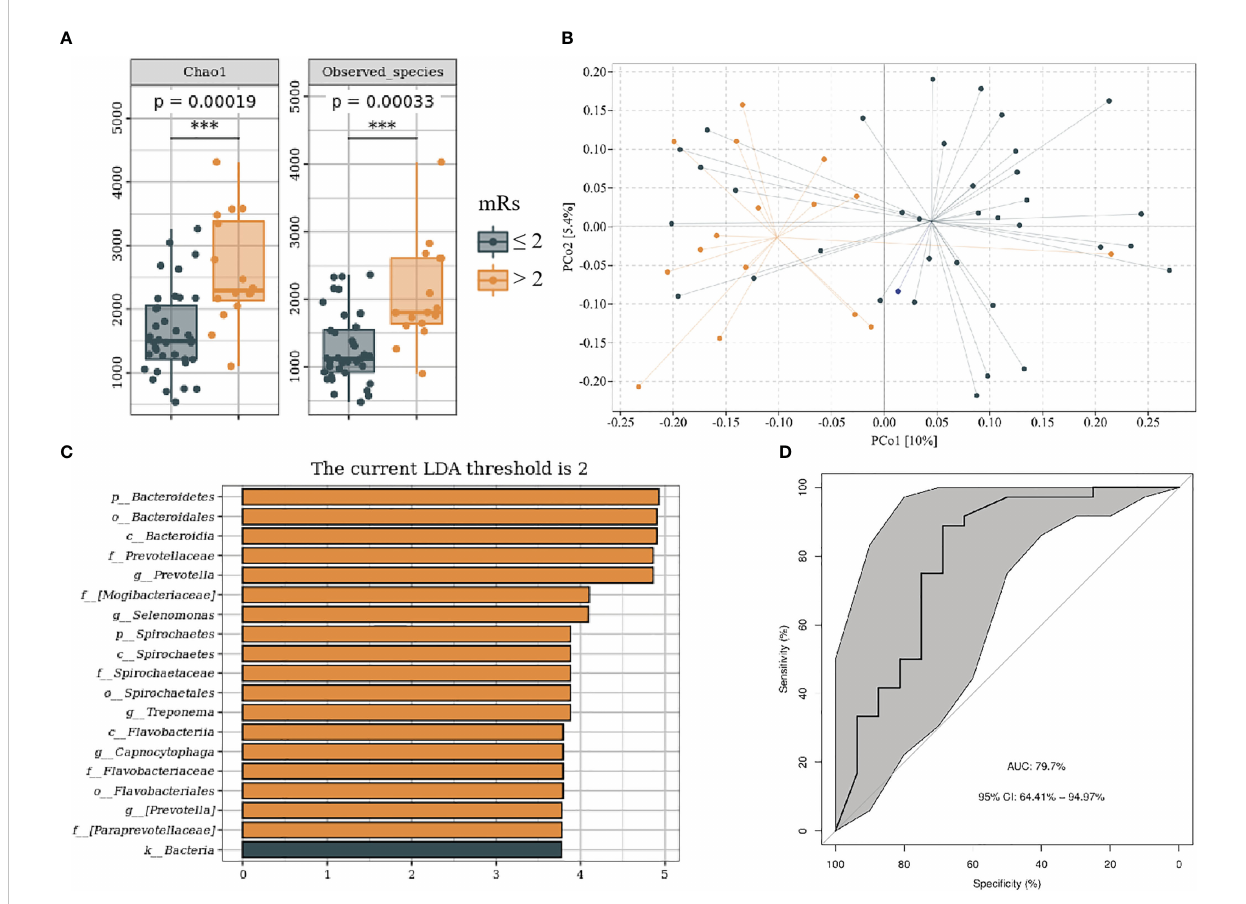
FIGURE 6 Oral microbiota composition of patients with mRs ≤ 2 and mRs > 2. (A) Comparison of a -diversity between the oral microbiota in two groups. (B) Principal coordinate analysis based on the unweighted UniFrac distances. (C) linear discriminant analysis effect size-determined differential features. (D) Machine learning for classi fi cation based on oral microbiota using the random forest algorithm. ***: P value ≤